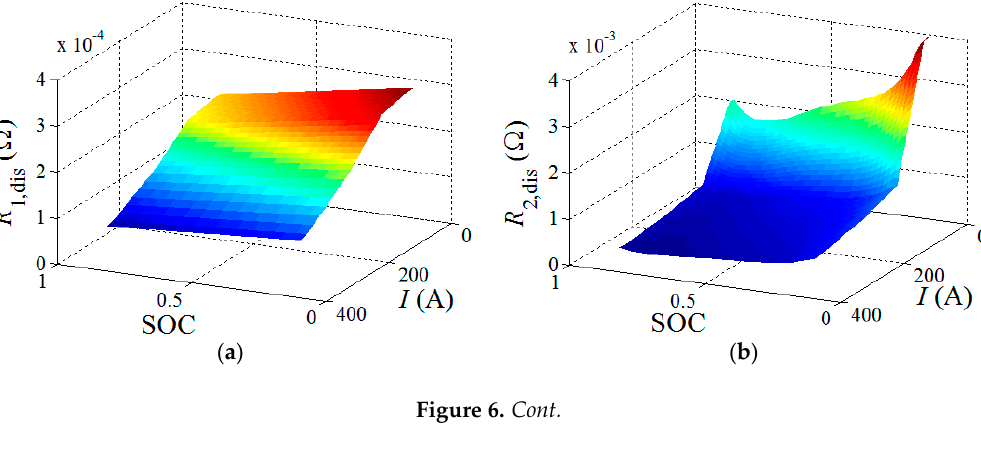
Figure 5. Identified parameters versus current at 50% SOC including ( a ) R 1 ; ( b ) R 2 ; ( c ) τ 1 , and ( d ) τ 2 .